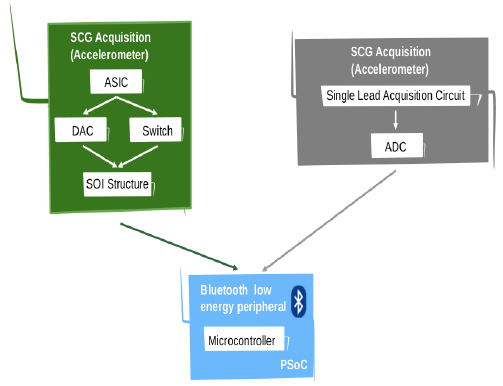
Figure 4. Block diagram of SCG contact-based acquisition